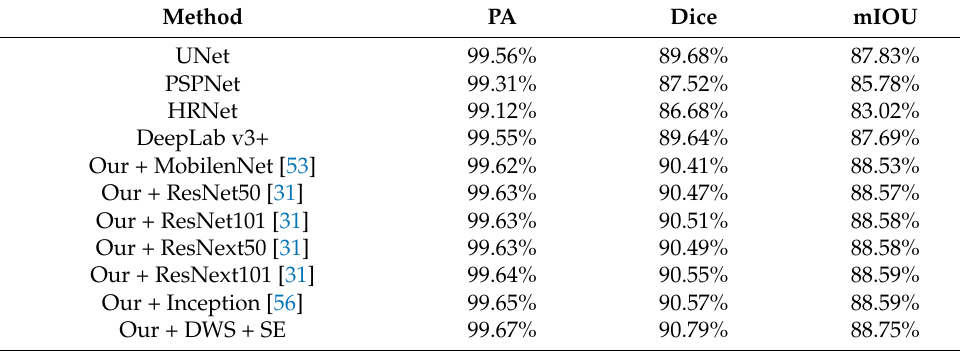
Table 3. Semantic segmentation model effectiveness comparison